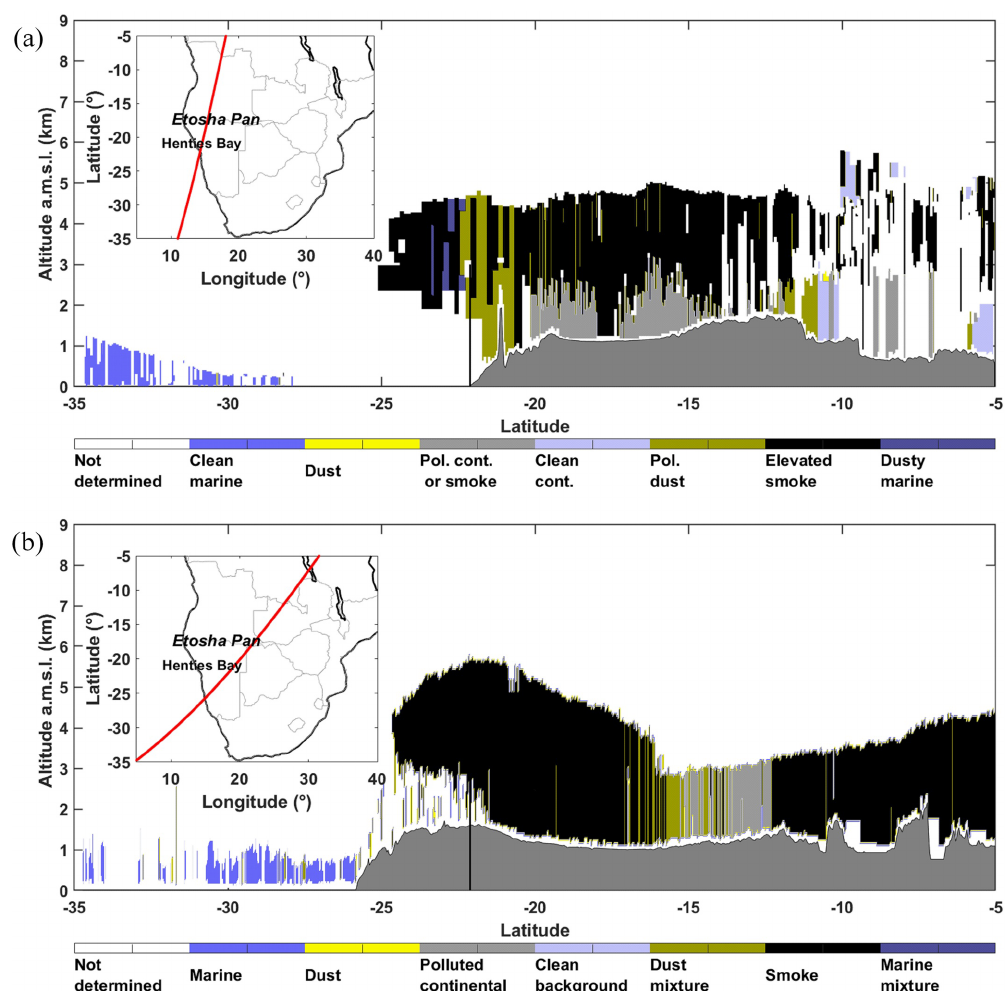
Figure A3. (a) CALIOP-derived aerosol types for the nighttime orbit (10.2017-08-28T00-08-17ZN) on 28 August 2017. (b) CATS-derived aerosol types for the nighttime orbit (2017-08-30T00-32-37T01-18-13UT) on 30 August 2017. The latitudinal location of the Henties Bay site is given by the vertical black line. Inserted panels in panels (a) and (b) show the position of the space-borne lidar tracks over southern Africa and with respect to Henties